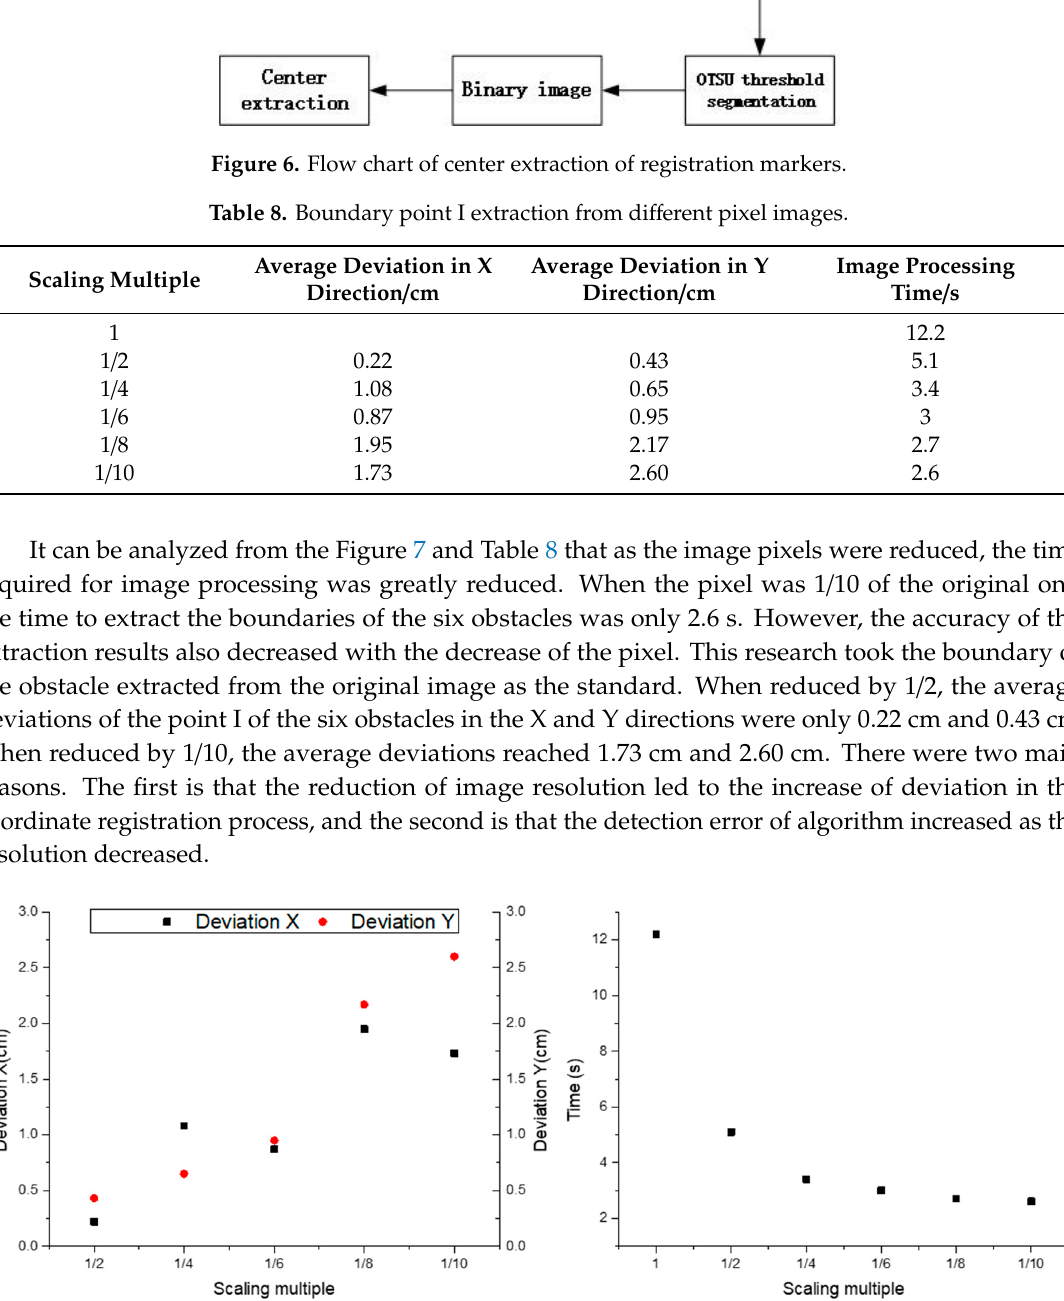
Figure 7. Boundary point I extraction from different pixel images. Table 8. Boundary point I extraction from different pixel images.